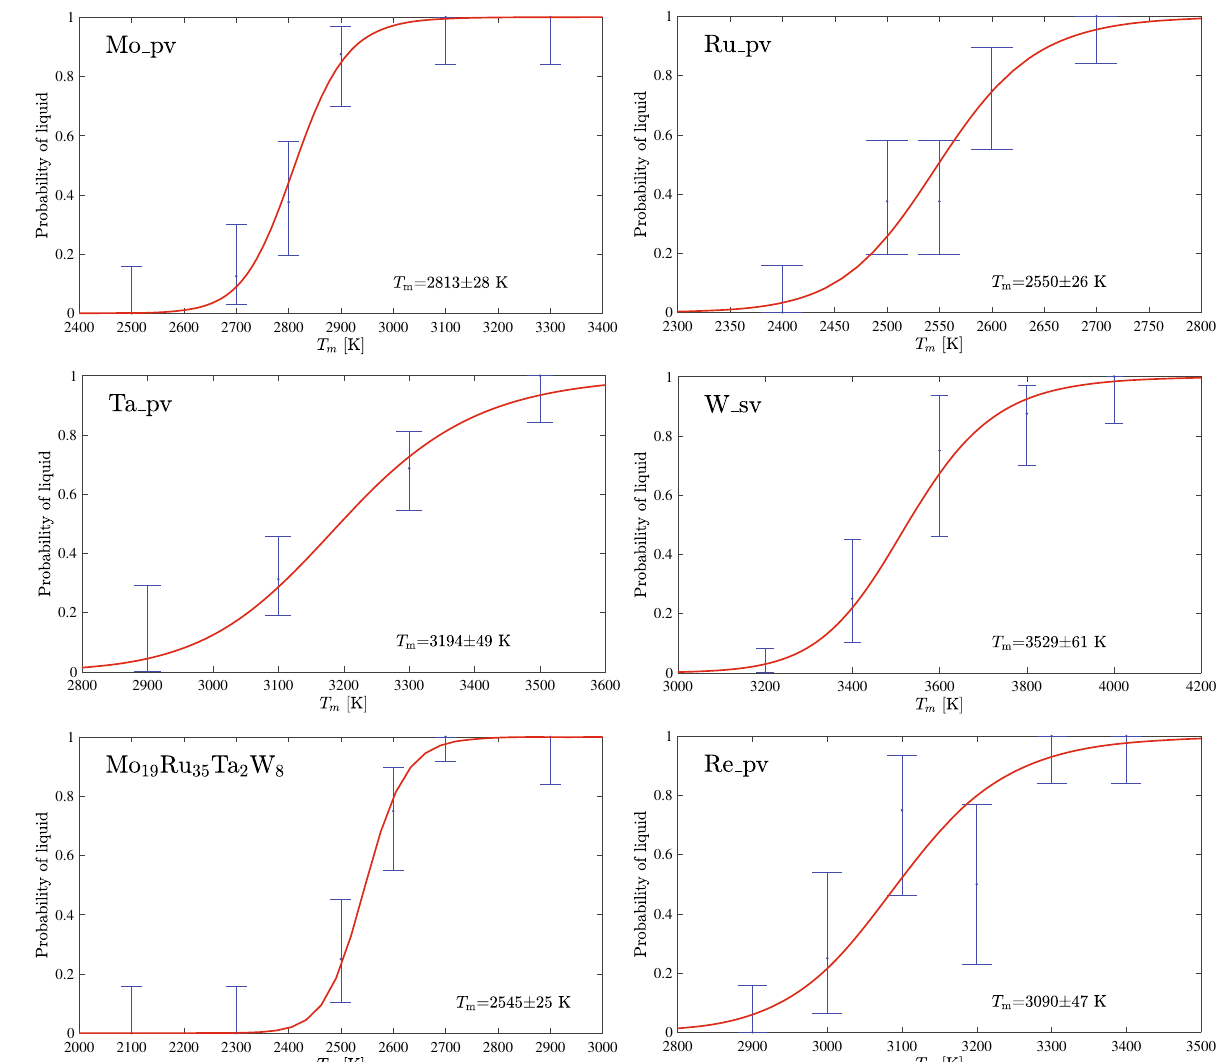
Fig. 1 Melting temperature calculations of Mo, Ru, Ta, W, Re and Mo 19 Ru 35 Ta 2 W 8 . Duplicates of solid-liquid coexistence simulations were performed at various temperatures near melting. Distribution of trajectories that completely solidify or liquidify were then analyzed statistically (blue). Melting temperatures are formally inferred based on fi tting (red) the statistical distributions. Error bars represent the standard error of binomial